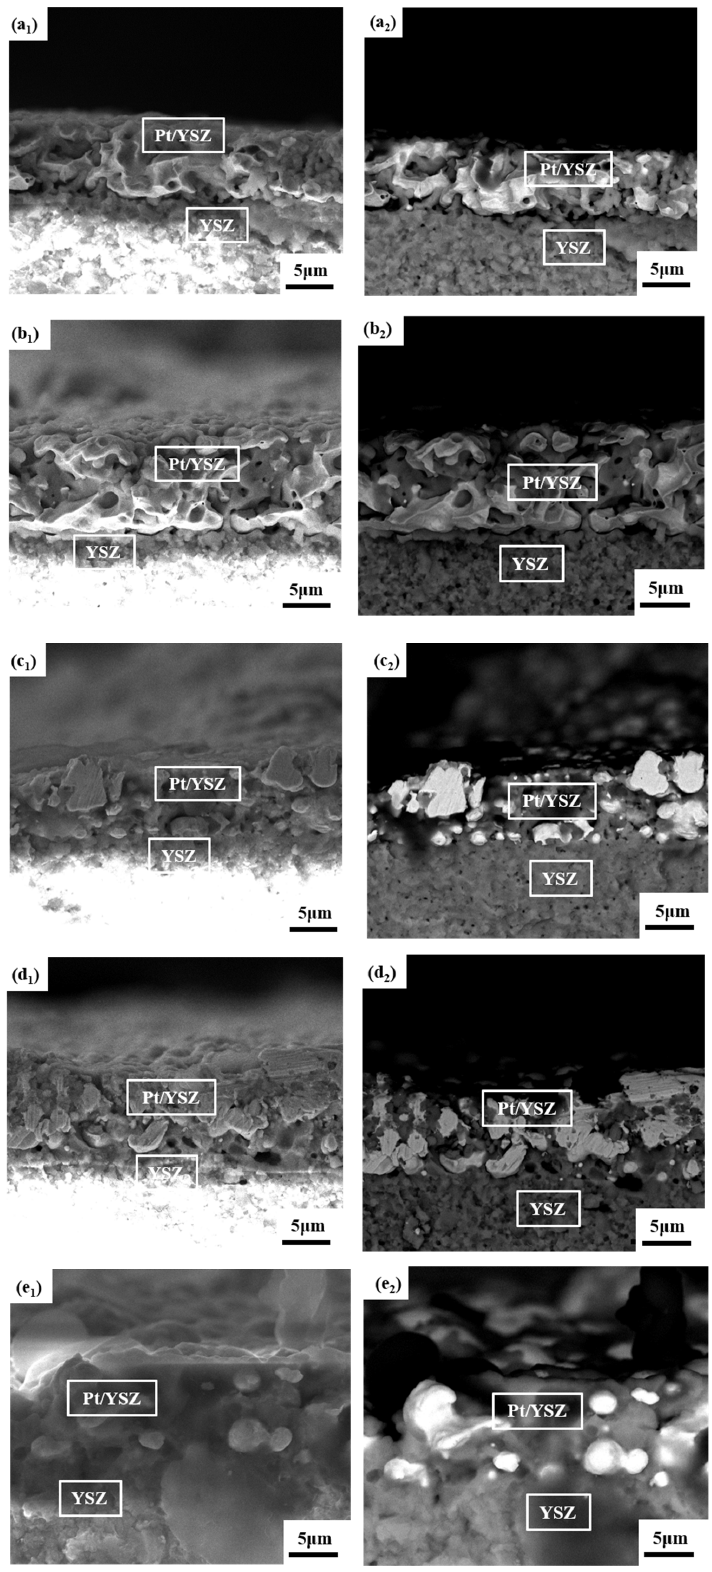
Figure 6. SEM morphologies of the interface of the Pt/YSZ electrodes and the YSZ electrolyte at different sintering temperatures. secondary electron image: ( a 1 ) 1350 °C, ( b 1 ) 1400 °C, ( c 1 ) 1450 °C, ( d 1 ) 1500 °C, ( e 1 ) 1550 °C. backscattered electron image: ( a 2 ) 1350 °C, ( b 2 ) 1400 °C, ( c 2 ) 1450 °C, ( d 2 ) 1500 °C, ( e 2 ) 1550 °C.